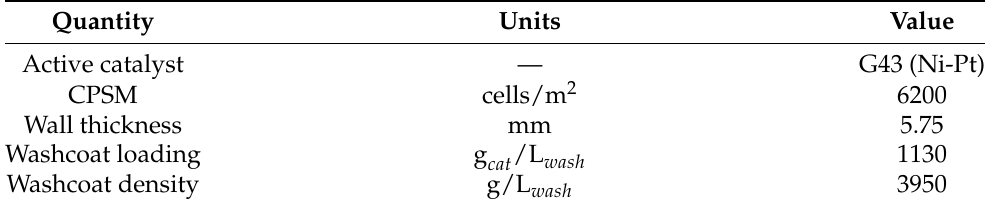
Table 8. The fixed characteristics of the marine ammonia cracking devices considered in this